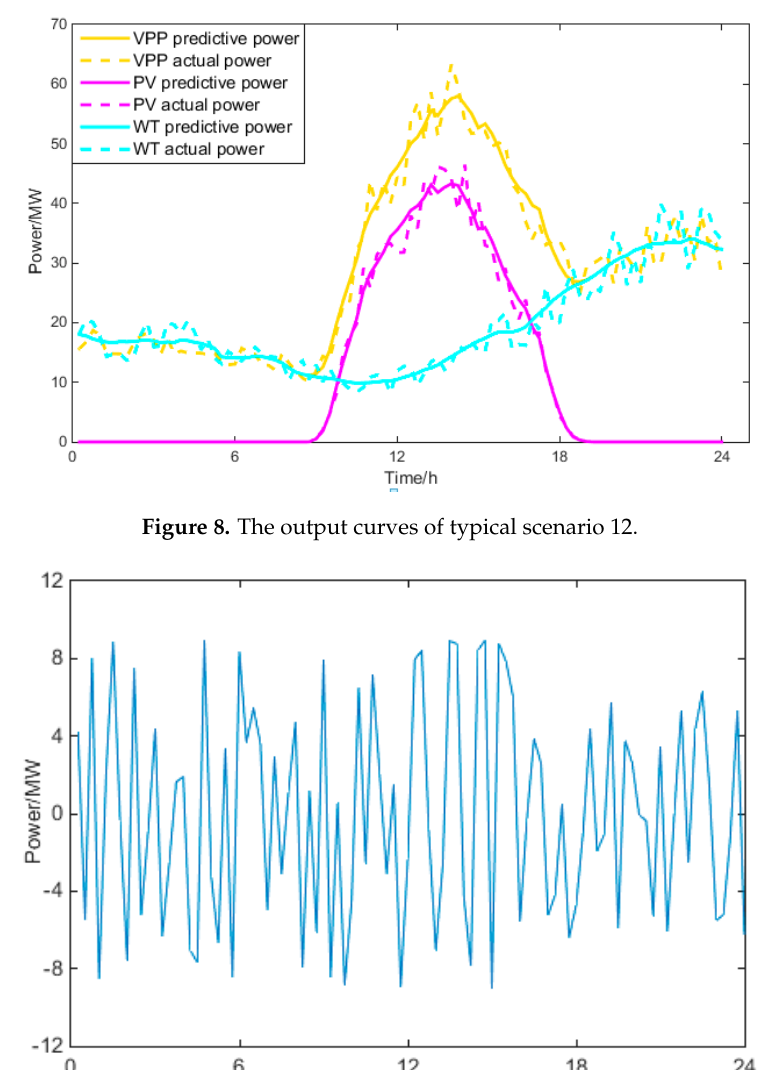
Figure 7. The output curve of energy storage resources of typical scenario 2.